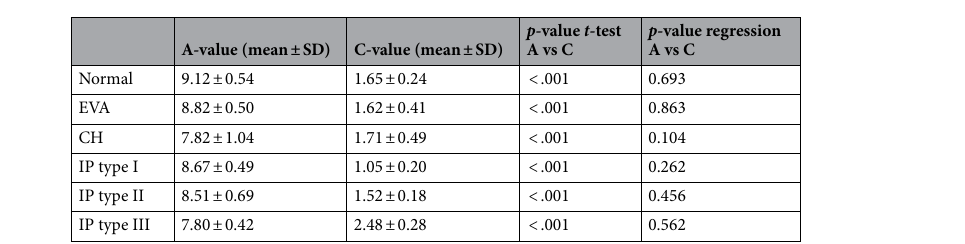
Figure 4. Comparison of mean ± standard deviation of A- and C-values of normal cochleae versus malformed cochleae (combined values of all the malformation types) captured from CT images used in this study. Asterisks indicate statistical significance where *** = p < 0.001 and NS not significant.